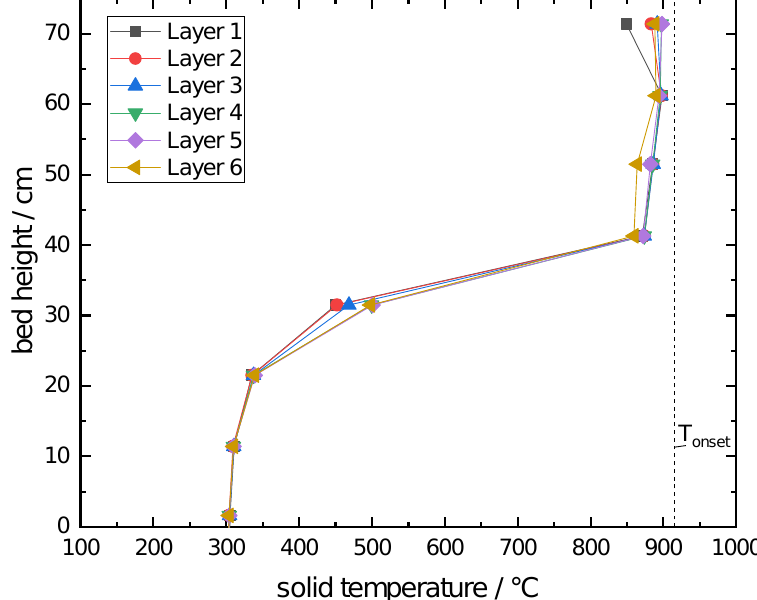
Figure 7. Development of the solid temperature of several layers (in 2cm distance to each other) along the bed height in the oxidation section. The temperature development is selected according to the theoretical bulk movement. The effective onset temperature of the oxidation of the manganese–iron oxides is added as a dashed